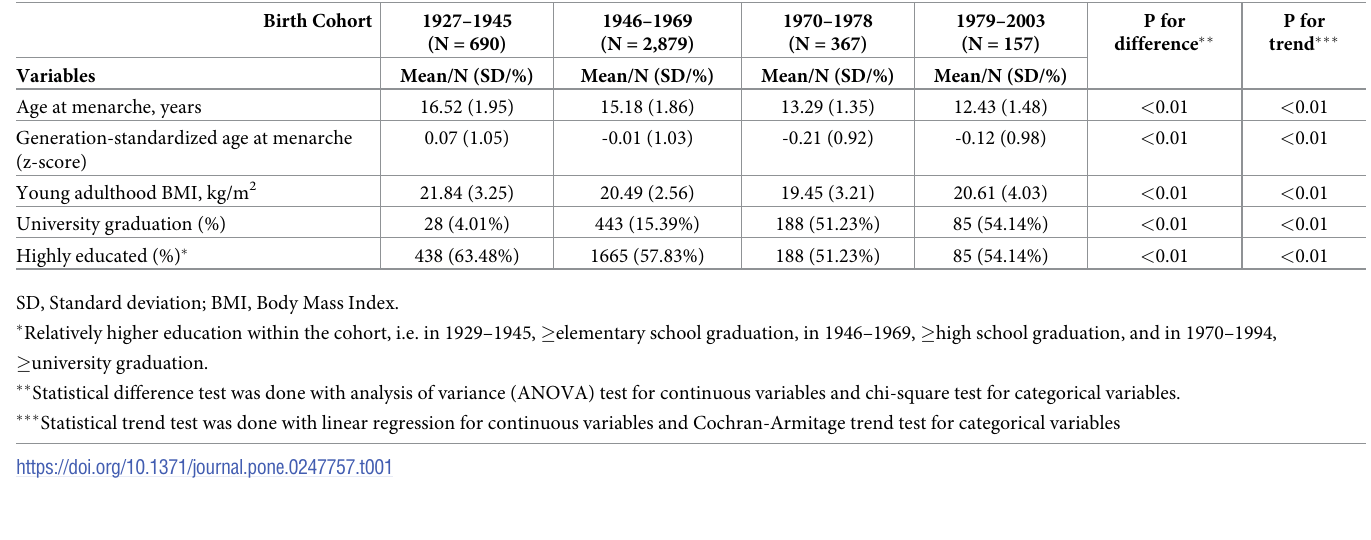
Table 1. Characteristics of study participants in the Korean Genome and Epidemiology Study (KoGES) and Healthy Twin Study (HTS), (n = 4,093 women). Birth